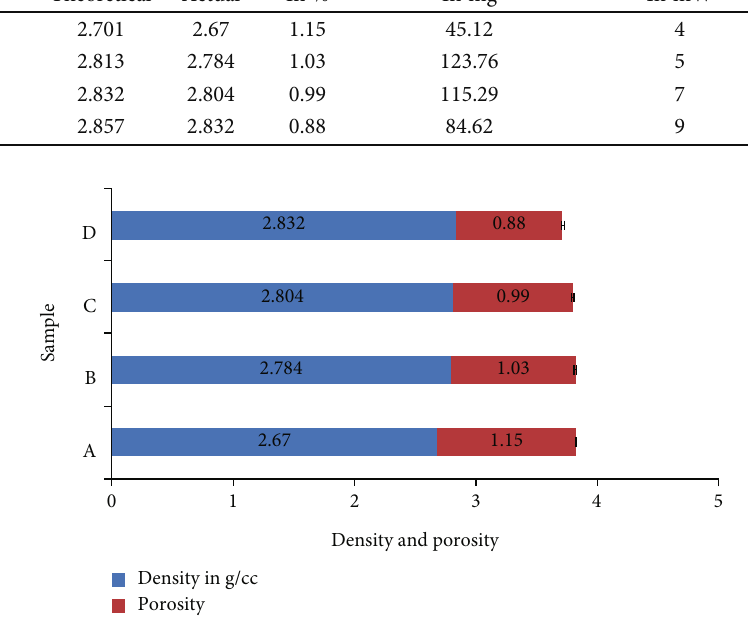
Figure 3: Density and porosity of AA6061/Si